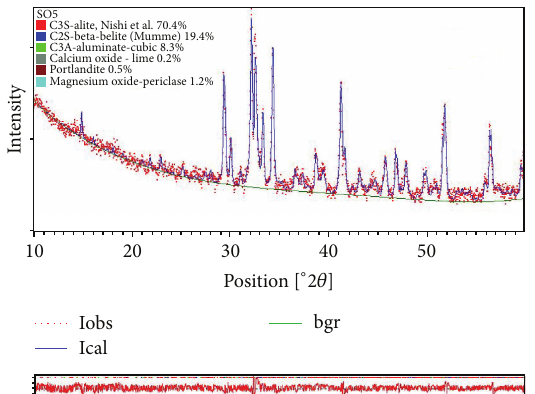
Figure 4: Rietveld refinement of the (SO5)